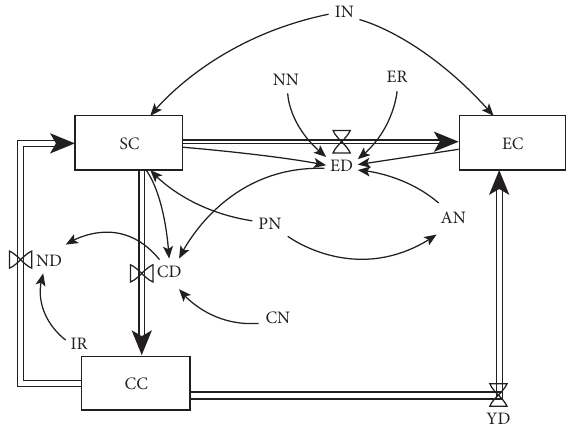
Figure 4: Infection subsystem flowchart.